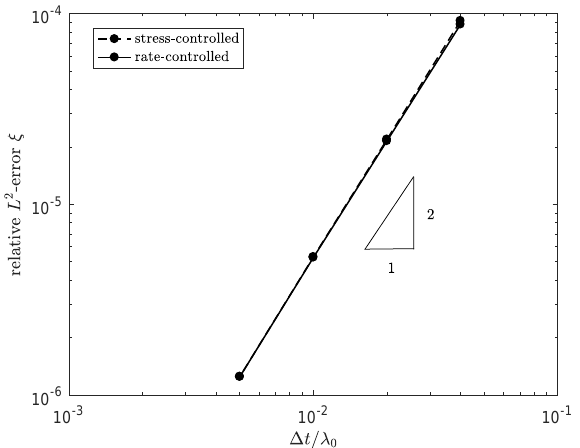
Figure 7. Relative error in ξ at the outlet of the channel at time t = λ 0 , for different time step sizes ∆ t for the rate and stress-controlled